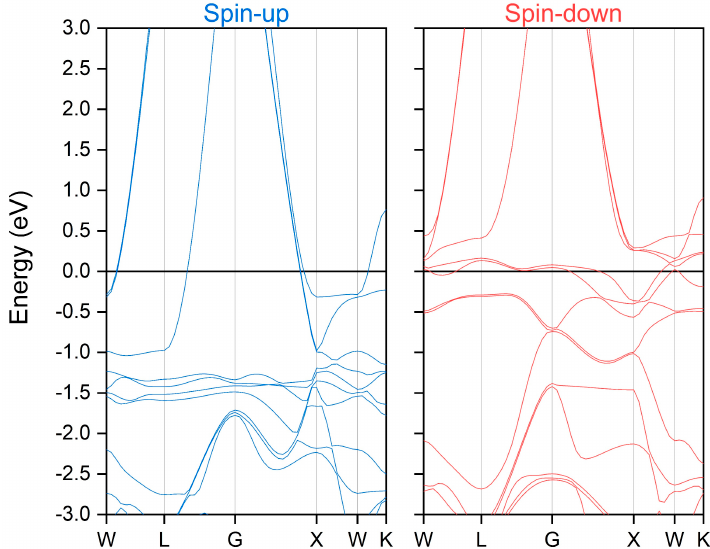
Figure 3. The calculated spin-polarized electronic band structures for the full Heusler compound Pd 2 CoAl in L2 1 -type cubic structure at the equilibrium lattice constant.